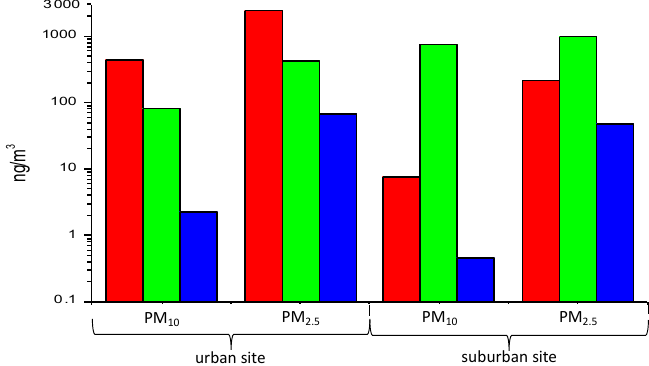
Figure 6. PAHs concentrations—sector #1 (air coming from the power plant) is the prevailing sector in U site, sector #2 (air coming from port area) in the UB site (red: sector #1; green: sector #2; blue: sector #3).